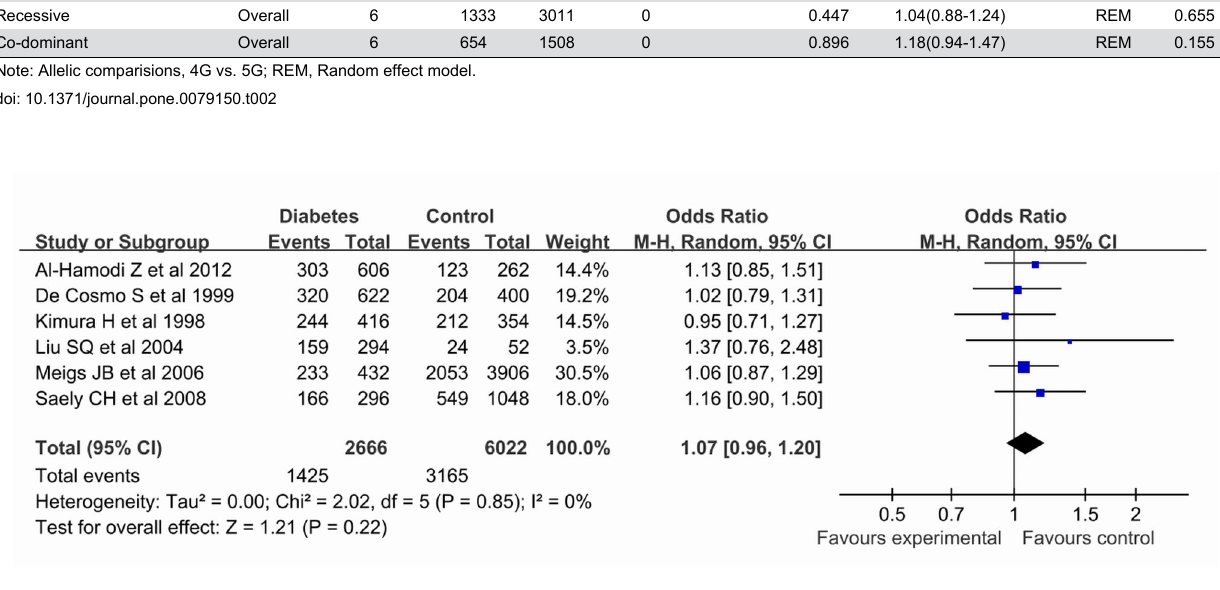
Figure 1. Pooled ORs for the association between the PAI-1 -675 4G/5G polymorphism (4G vs. 5G) and susceptibility to diabetes. The area of the squares reflects the study-specific weight. The diamond shows the summary fixed-effects OR estimate from 6 studies.